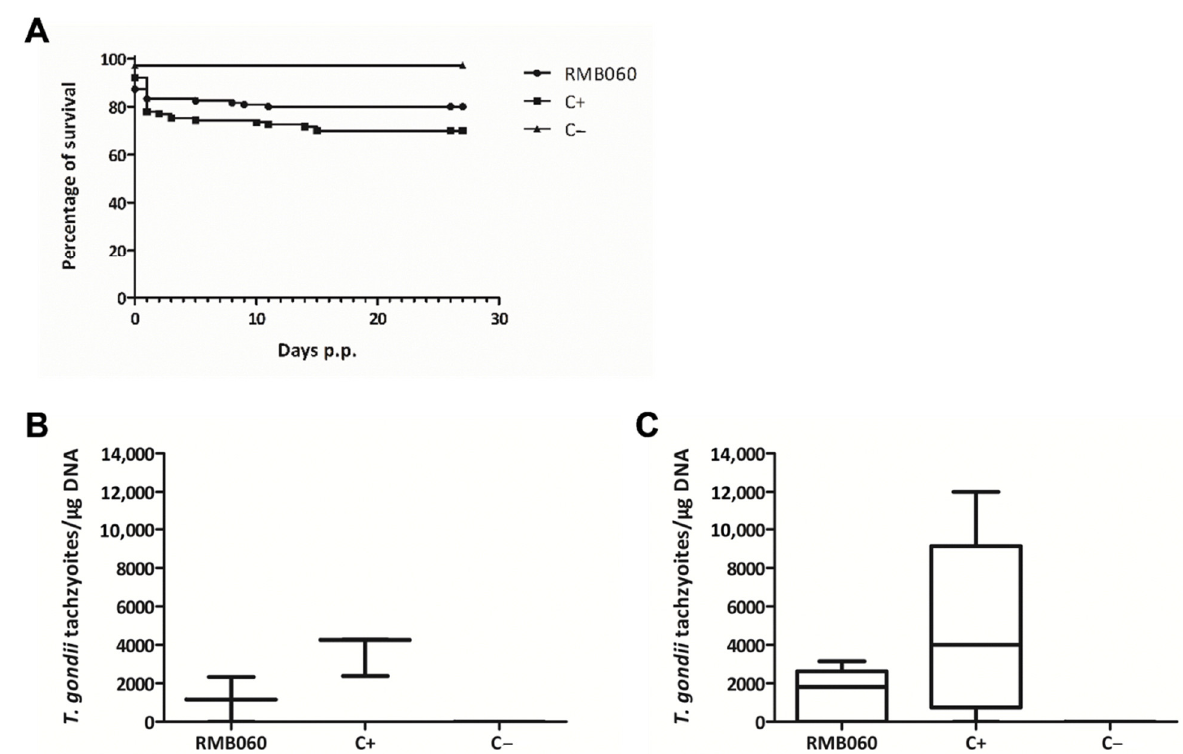
Figure 6. RMB060 treatment in the pregnant toxoplasmosis mouse model. Survival curves of pups ( A ) and cerebral parasite burden of non-pregnant mice ( B ) and dams ( C ). Survival rates were plotted in Kaplan–Meier graphs at each time point and curves were compared by the Log-rank (Mantel-Cox) test. No statistically significant differences were observed between the survival curves of the RMB060 group and the C+ group. CD1 mice were infected with 100 TgShSp1 oocysts and treated with 10 mg/kg RMB060, while C+ was infected and treated only with corn oil. C − was not infected and treated with corn oil alone. Four weeks p.p., all mice were euthanized, brains were aseptically collected, and cerebral parasite burden was quantified by real-time PCR. The values are depicted as box plots and parasite burden between groups were compared by the Kruskal–Wallis test, followed by the Mann-Whitney U test. No statistically significant differences in the cerebral parasite burden were observed between RMB060-treated mice compared to the C+ group (neither in non-pregnant mice nor in dams).